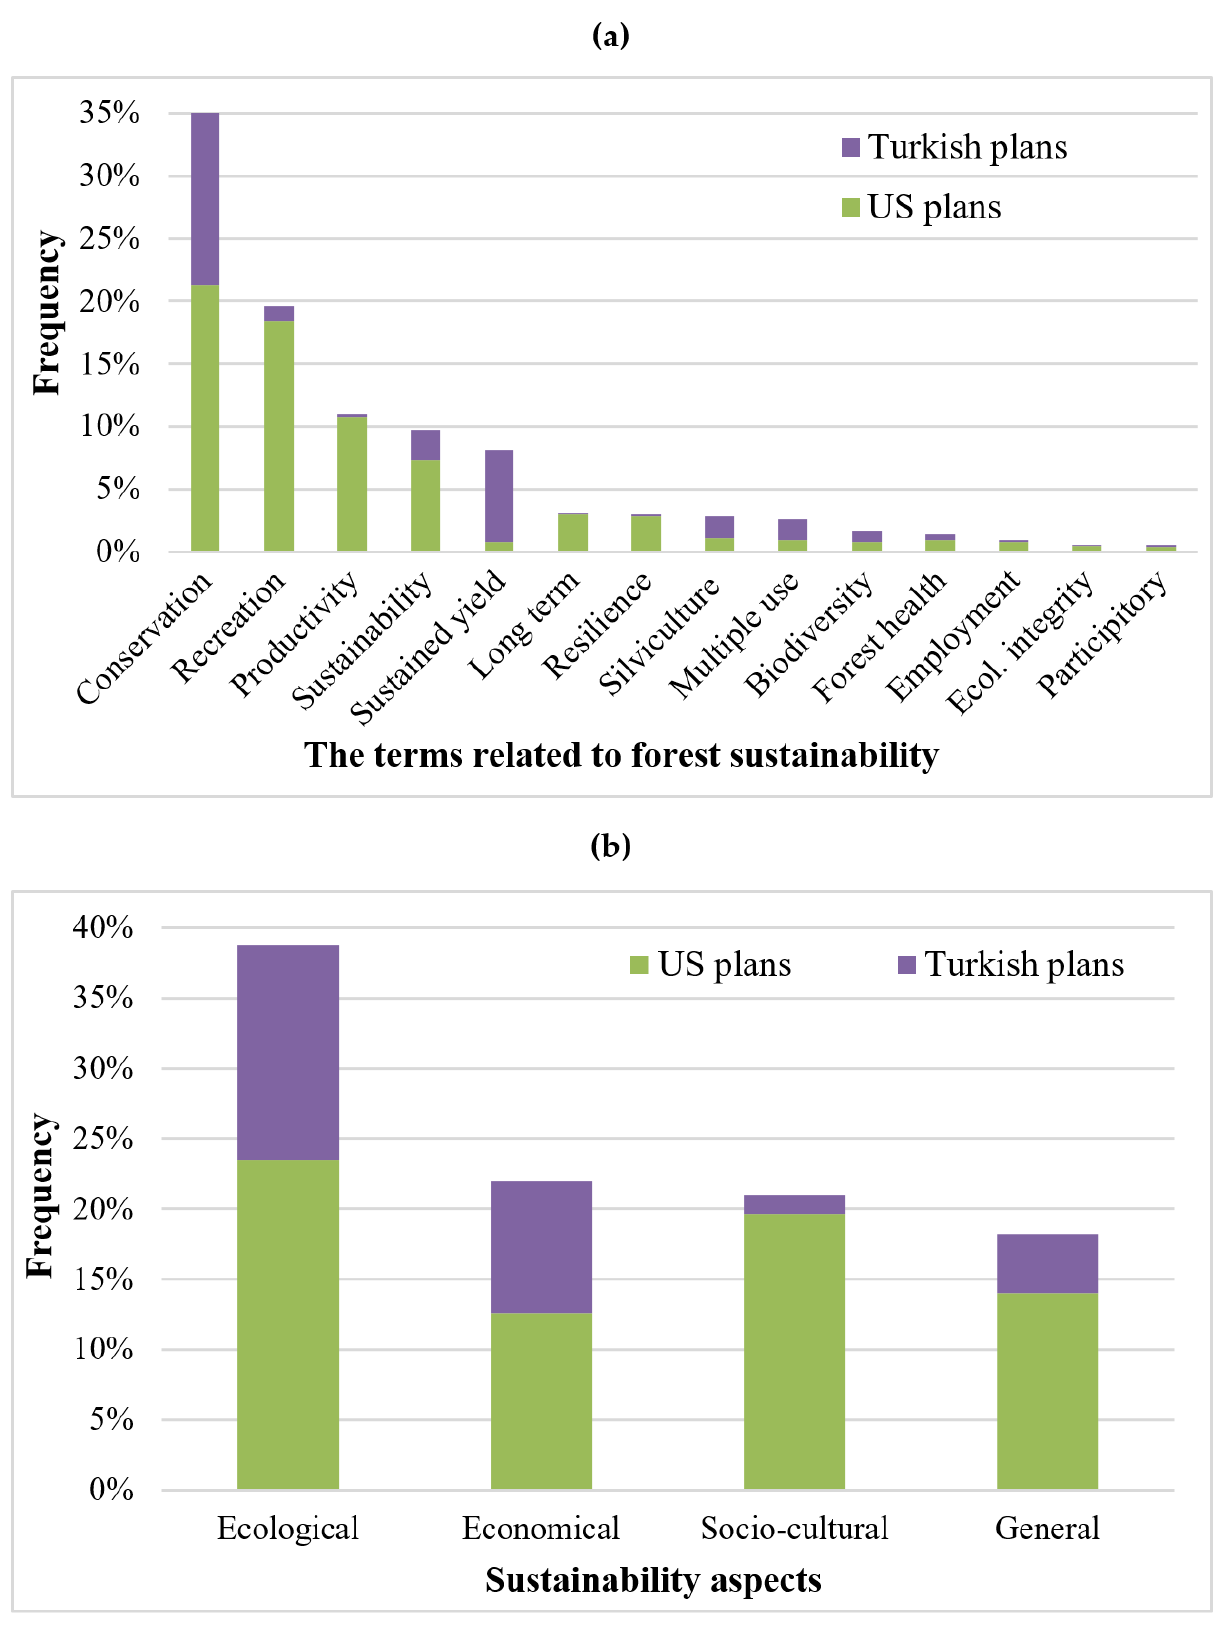
Figure 1. Frequency distributions of terms ( a ) and sustainability aspects ( b ) in forest plans from the two countries ( n = 42).